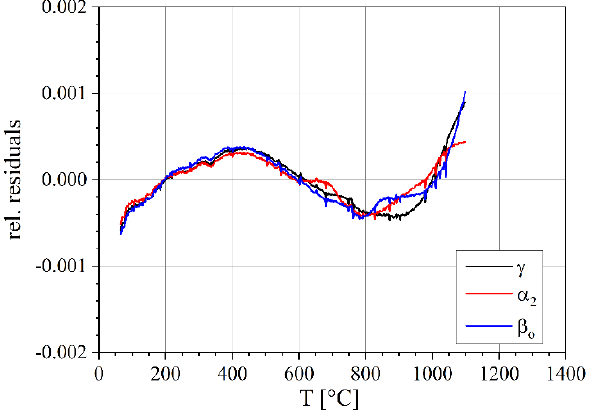
Figure 10. Relative residuals of fitting with a polynomial of rank 2 (heating).